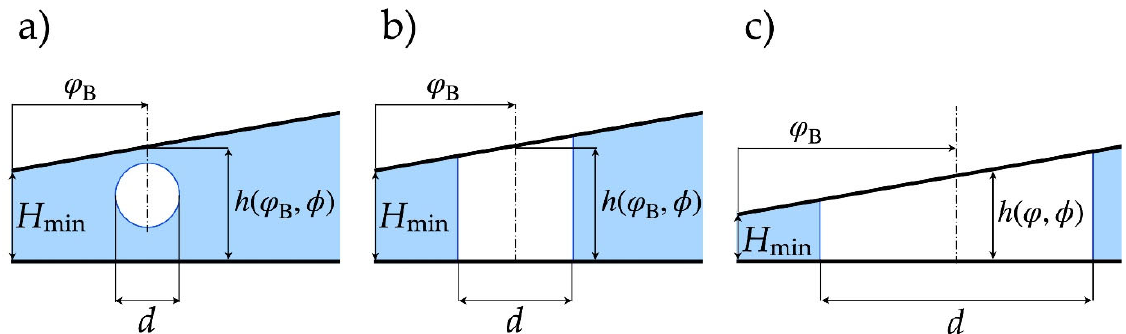
Figure 7. Phases of bubble growth in a narrow gap flow: ( a ) inception phase with gaseous cavitation, ( b ) interim phase with a combination of gaseous and pseudo ‐ cavitation, ( c ) final phase of bubble growth with solely pseudo ‐ cavitation.